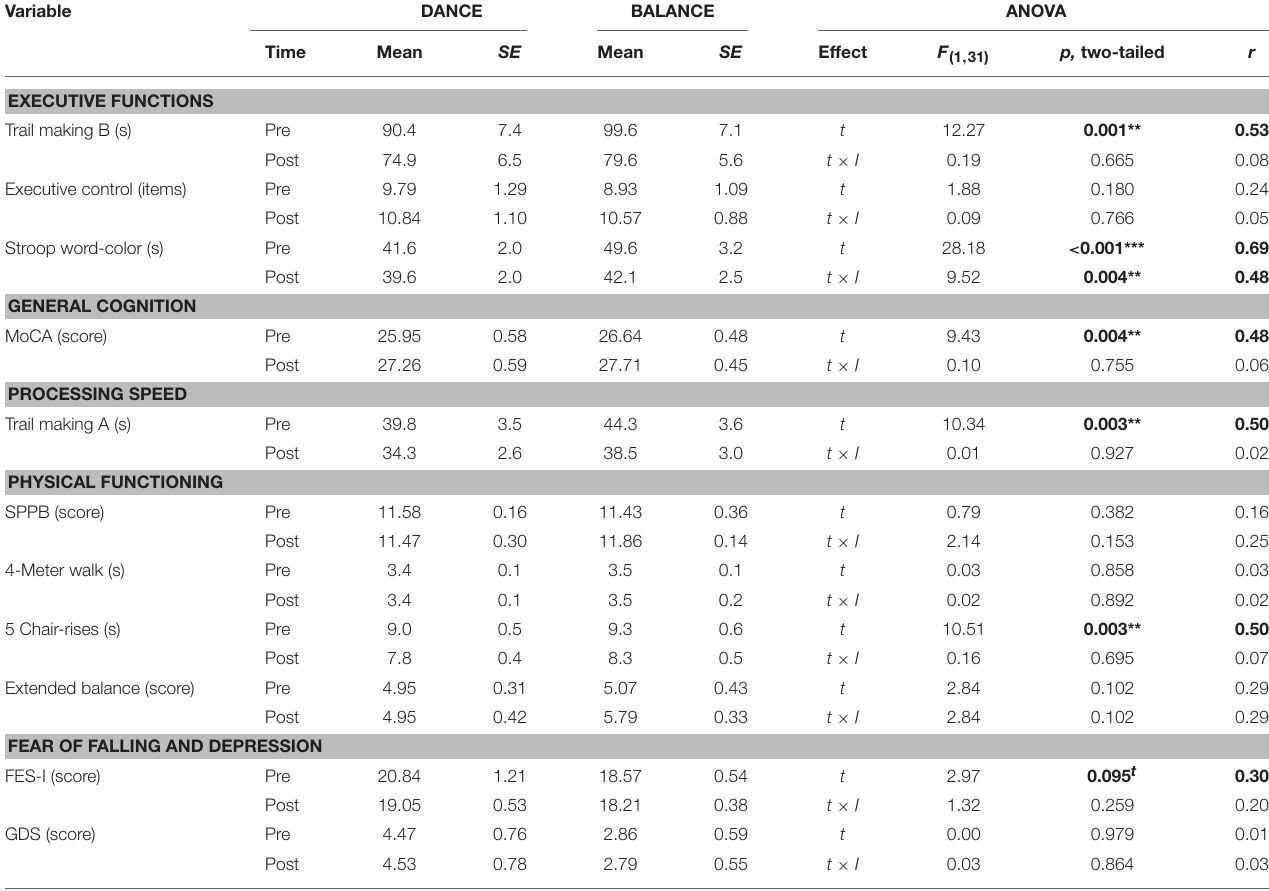
TABLE 7 | Performance and statistical data of secondary assessments. Variable DANCE BALANCE ANOVA Mean SE